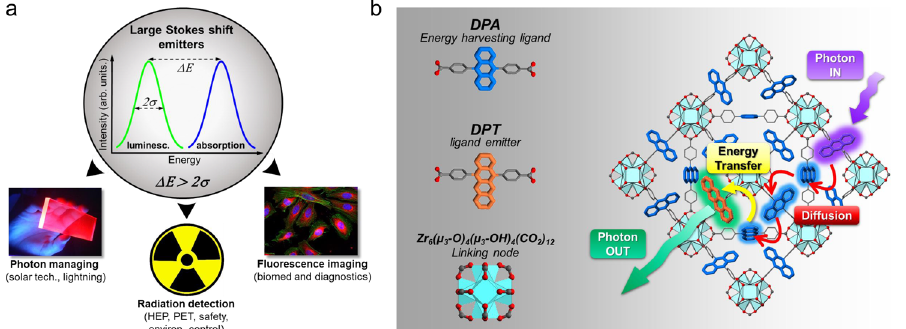
Fig. 1 Large Stokes shift emitters concept, applications and realization with engineered hetero -ligand MOF nanocrystals based on fl uorescent ligands. a De fi nition of large Stokes shift emitter. The energy difference between absorption and luminescence maxima ΔΕ is larger than luminescence half-height bandwidth 2 σ , thus avoiding reabsorption. b (left) Molecular structure of the MOF nanocrystals building blocks, namely the 9,10-diphenyl- antracenedicarboxylate fl uorescent ligand (DPA), the 5,12-diphenyl-tetracenedicarboxylate fl uorescent co-ligand (DPT) and the linking node zirconium oxo-hydroxy cluster. (right) Sketch of the energy fl ux after generation of a DPA singlet exciton, in this case upon absorption of a UV photon of energy h ν in . The singlet exciton diffuses within the crystalline framework until it reaches the co-ligand DPT. The latter is excited by non-radiative energy transfer and then recombines radiatively by emitting a green photon of energy h ν out with a Stokes shift ΔΕ = hv in − hv out